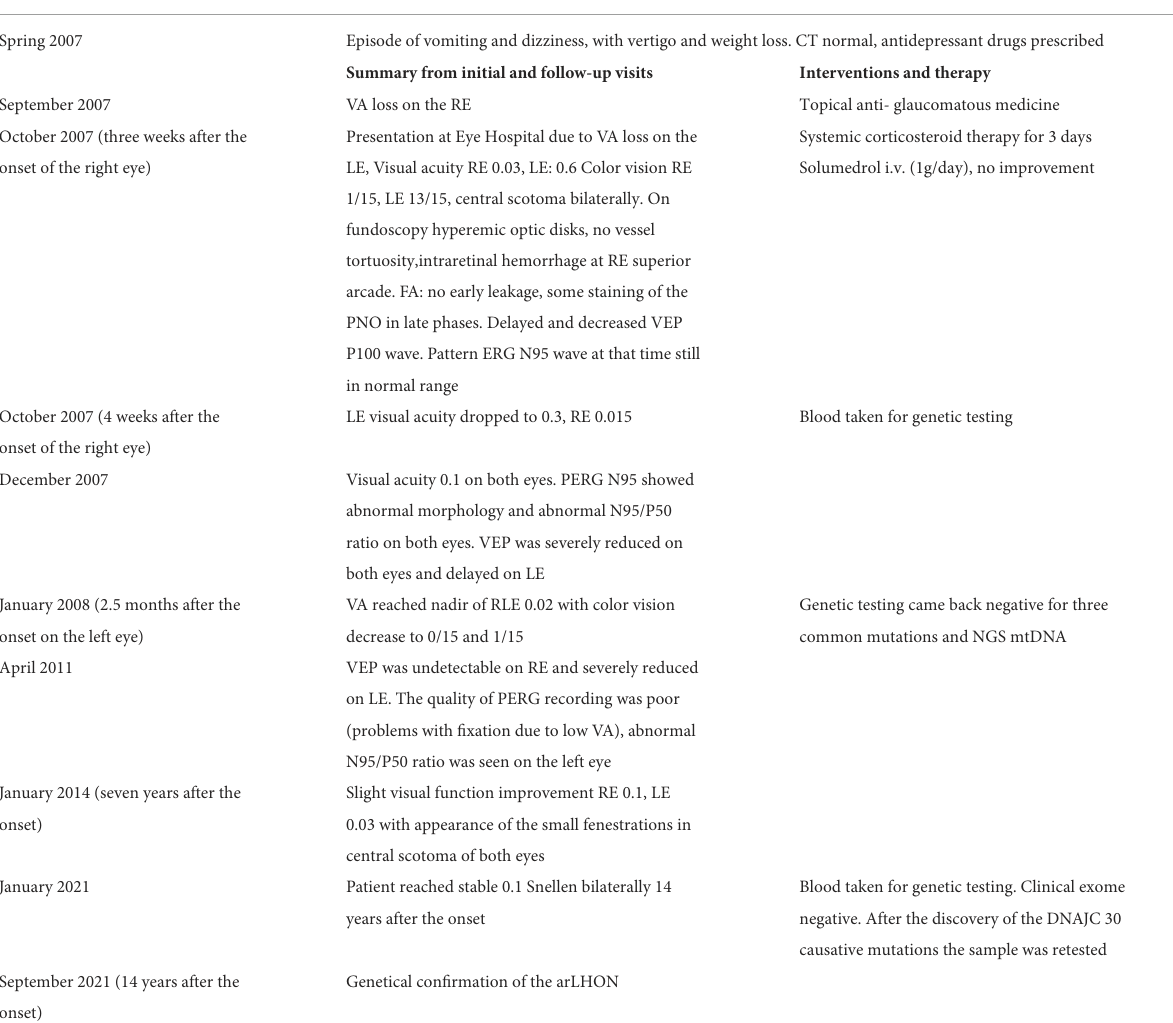
TABLE 1 Medical history and disease progression in the Case